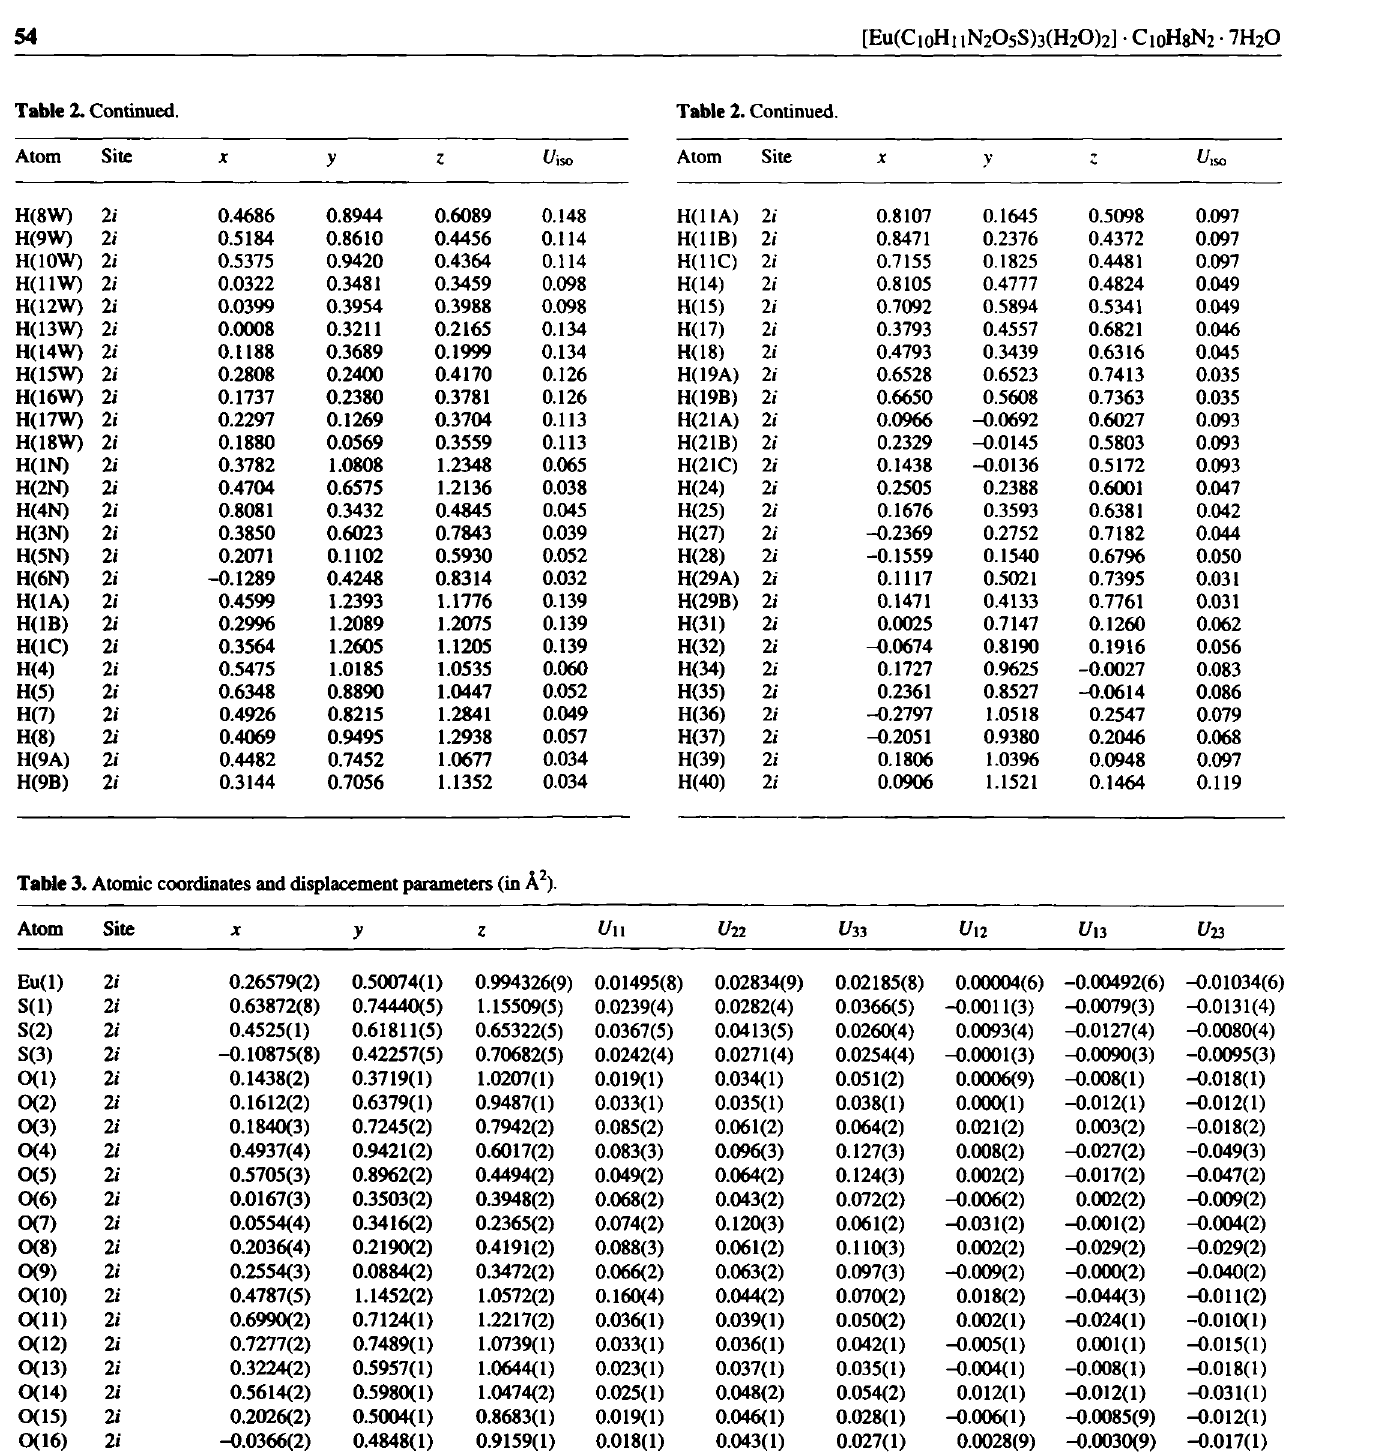
Table 3. Atomic coordinates and displacement parameters (in Â 2